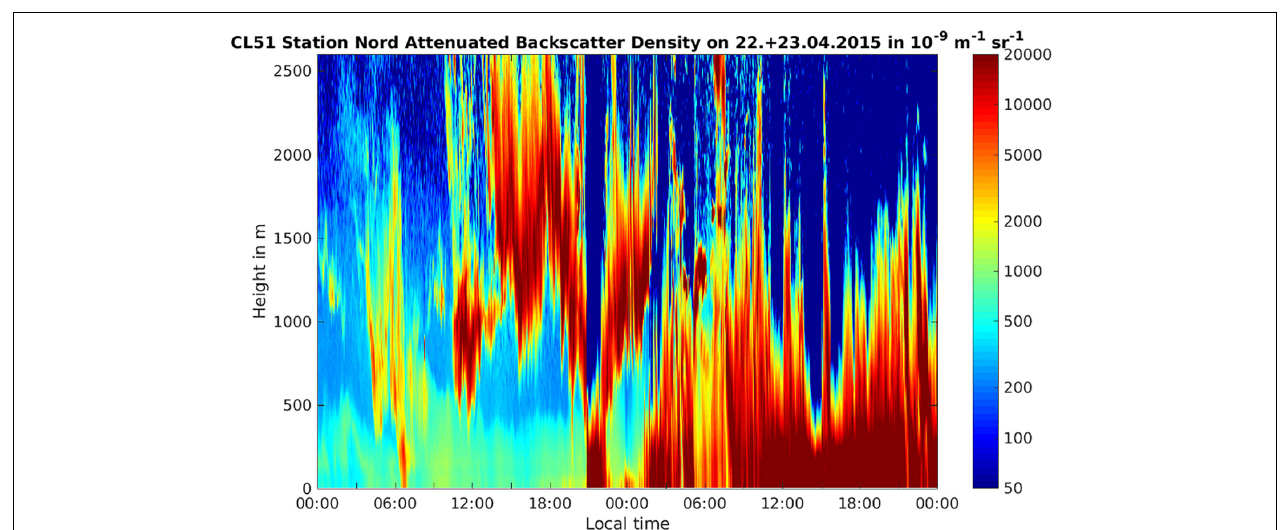
FIGURE 5 | Attenuated backscatter density (units 10 − 9 sr − 1 m − 1 ) on the day of the onset of the storm (22 April 2015) and the following day from the ground up to 2,500 m height. The clouds associated with the storm are shown by red/brown colors indicating high values of the attenuated backscatter. It can be seen that the cloud systems move in at around 12 pm on 22 April, reaches ground level at around 21 pm, then ascends up > 500 m for approx. 3 h before descending and then remains in contact with the ground for the whole of the 23rd of